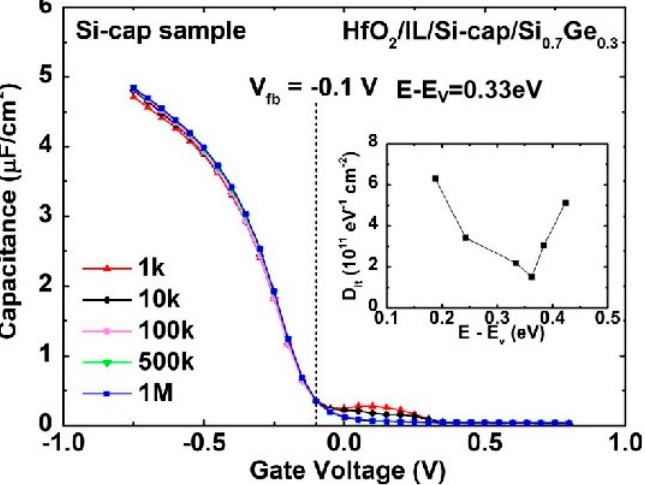
Figure 4. Multi ‐ frequency C ‐ V characteristic of W/TiN/HfO 2 /IL/Si ‐ cap/Si 0.7 Ge 0.3 MOS capacitor with 1 nm Si ‐ cap.